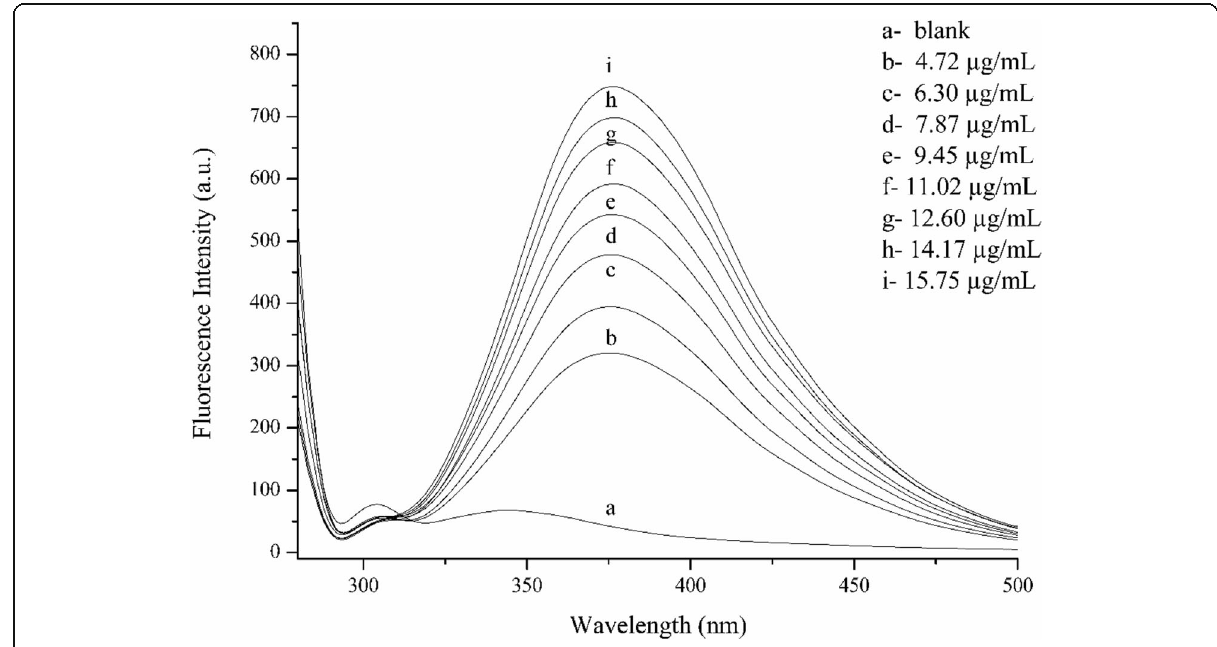
Fig. 8 UV-spectrums of the tenofovir calibration